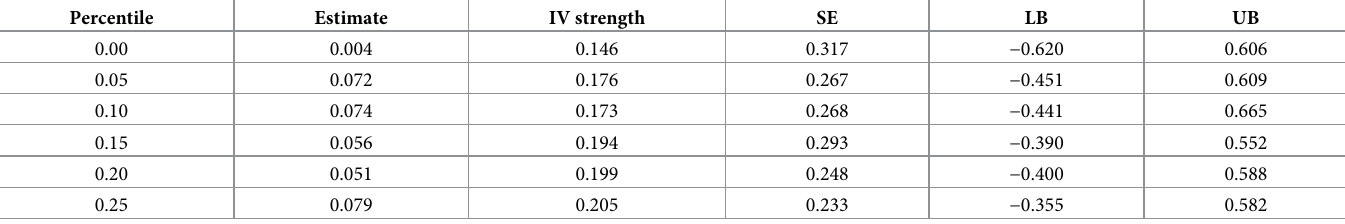
“SE” is the standard error of the LATE or TLATE estimate. “LB” and “UB” are the lower and upper bounds of the 95% confidence